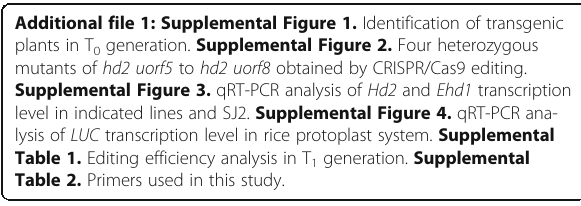
Additional file 1: Supplemental Figure 1. Identification of transgenic plants in T 0 generation. Supplemental Figure 2. Four heterozygous mutants of hd2 uorf5 to hd2 uorf8 obtained by CRISPR/Cas9 editing. Supplemental Figure 3. qRT-PCR analysis of Hd2 and Ehd1 transcription level in indicated lines and SJ2. Supplemental Figure 4. qRT-PCR ana- lysis of LUC transcription level in rice protoplast system. Supplemental Table 1. Editing efficiency analysis in T 1 generation. Supplemental Table 2. Primers used in this